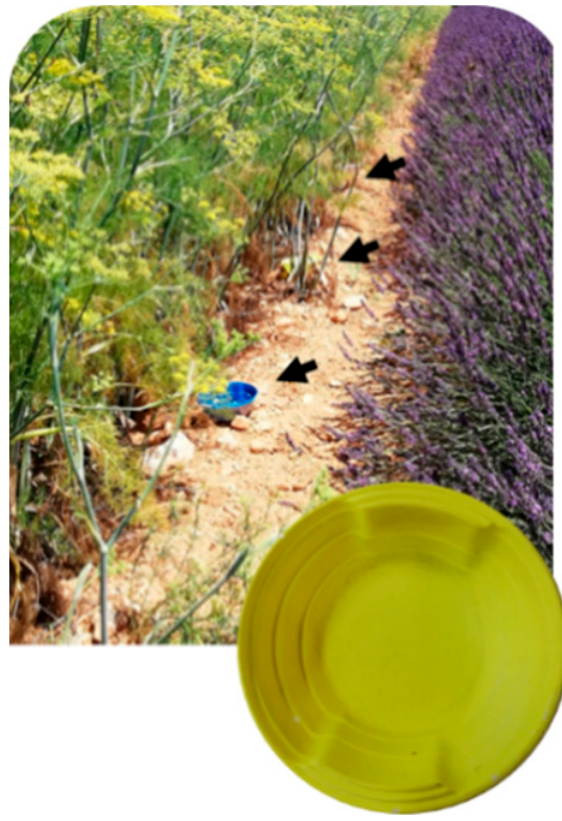
Figure A1. Pan-trap type used to insect captures.